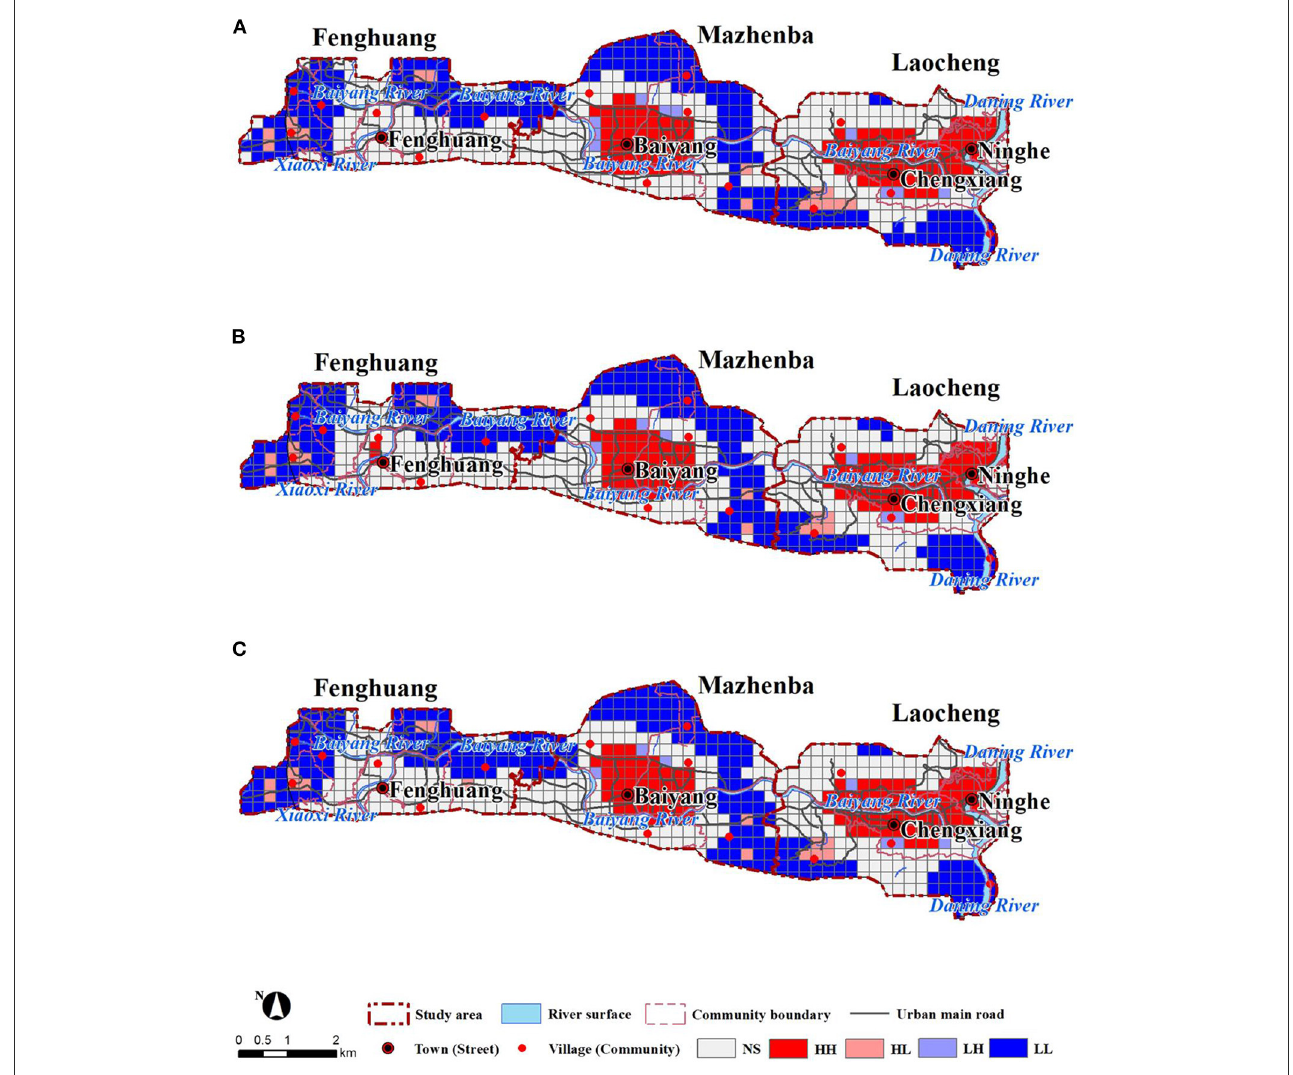
FIGURE5 Spatial matching of environmental comfort and urban vitality: morning (A) , afternoon (B) , and evening (C)